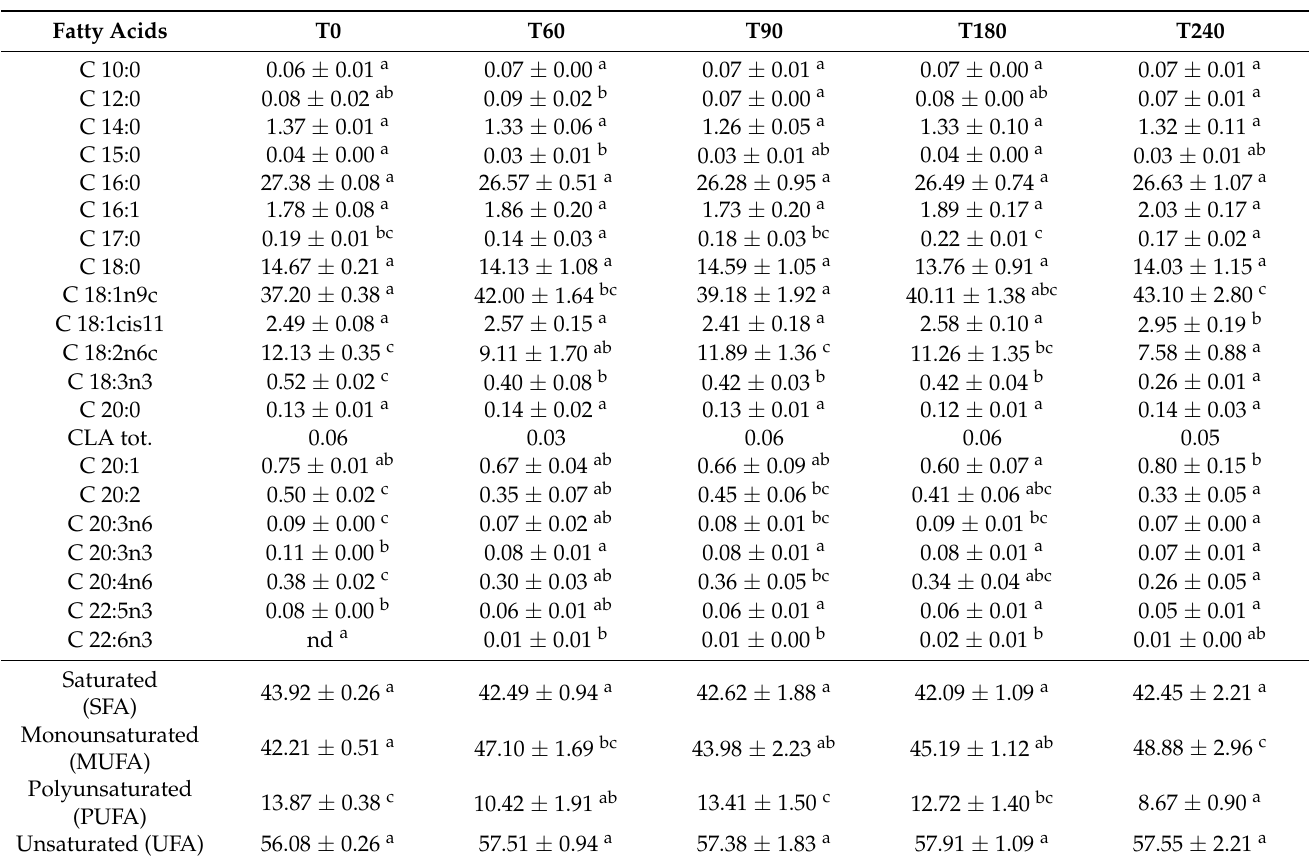
Table 2. Fatty acid profile (% total fatty acids) of Coppa Piacentina PDO samples collected at different ripening times. Values followed by different letters within one column are significantly different ( p < 0.05). nd: not detected (i.e., <limit of